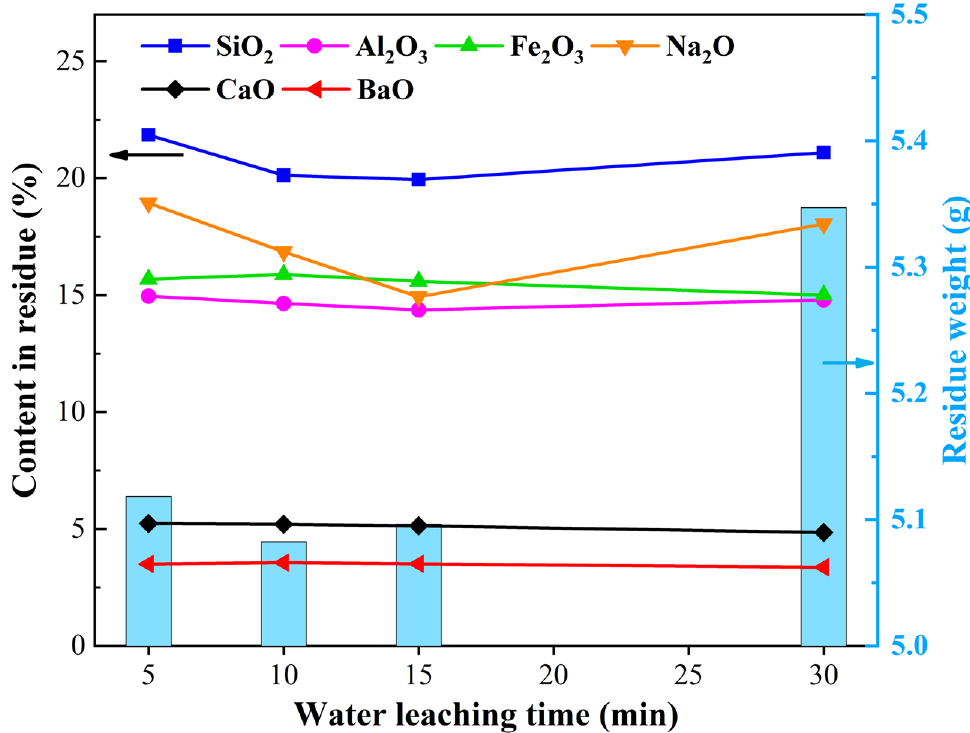
Figure 5. The element contents and the weight of water leaching residues. The morphological images and the related EDS results of the water leaching residues at different times under the conditions of leaching temperature 353 K and liquid–solid ratio of 10 mL/g are shown in Figures 7 and 8. Figure 7 shows the SEM photograph and EDS analysis of the 5 min water leaching residue. It can be observed from the SEM photo that the 5 min water leaching residue contained massive grains with a particle size of about 100 µ m, as well as minor particles of 20–30 µ m scattered around the massive grains. The surface of the particles was rough and fractured. The results of the EDS analysis show that the massive particles were a mixture phase containing multiple elements, as well as